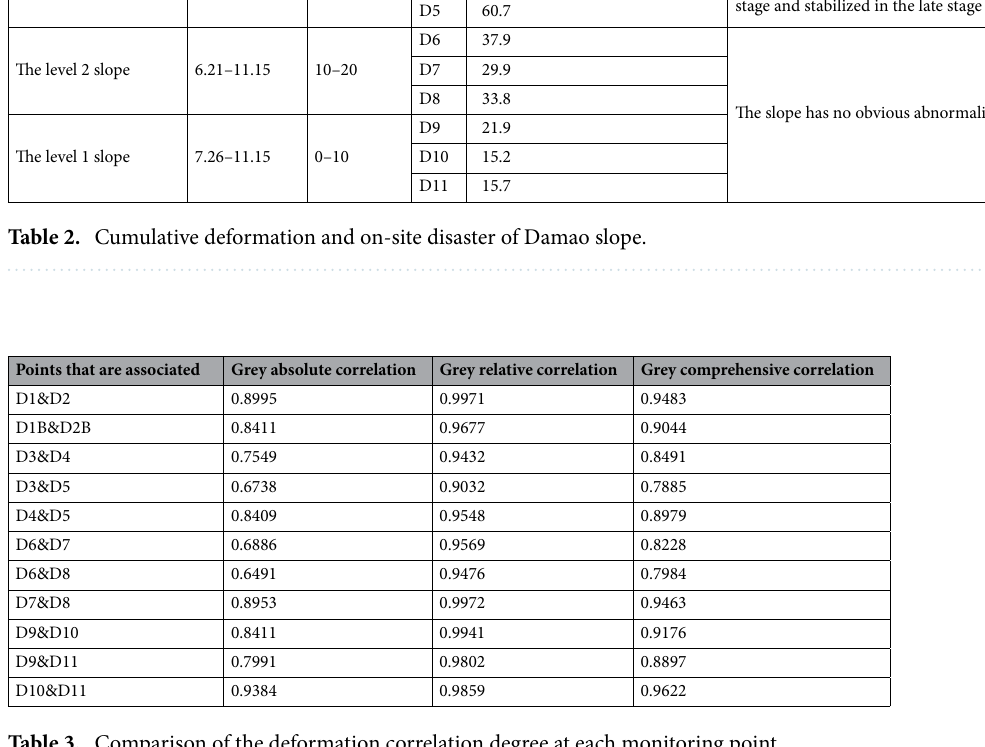
Table 3. Comparison of the deformation correlation degree at each monitoring